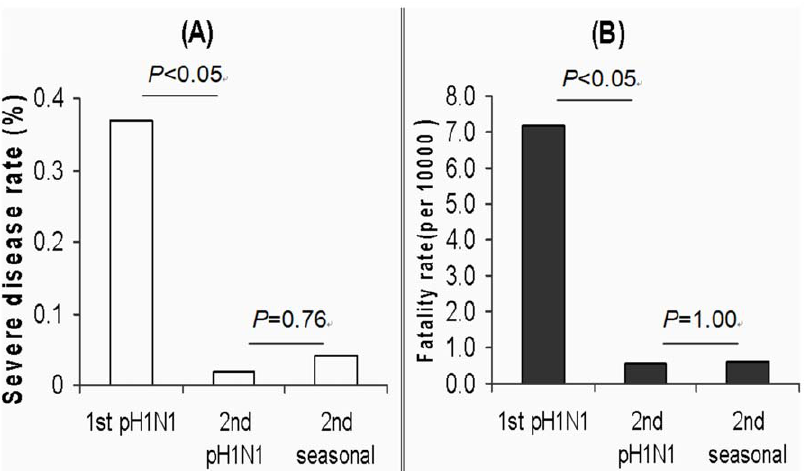
Figure 1. Severe disease and fatality rates of pH1N1 and seasonal influenza in Guangzhou. (A) Severe disease rate (% of patients progressed to severe disease) of pH1N1 influenza in the first (1st pH1N1) and second (2nd pH1N1) epidemic year and of seasonal influenza in the second epidemic year (2nd seasonal). (B) Fatality rate (deaths/10000) of pH1N1 influenza in the first (1st pH1N1) and second (2nd pH1N1) epidemic year and of seasonal influenza in the second year (2nd seasonal).